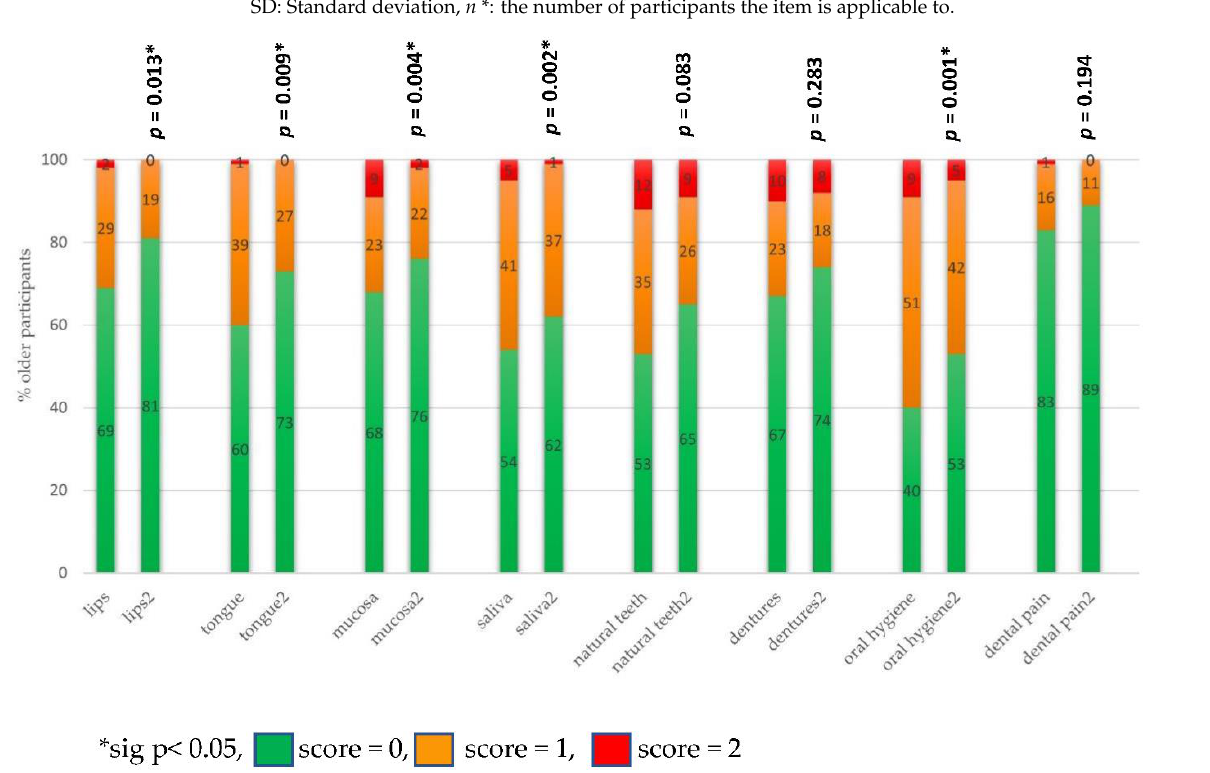
Figure 3. OHAT scores on different categories t0 and t1. Frequencies of the sum scores on OHAT at baseline and after 3 months were calculated. Participants scored lower sum scores after participating in the OCP: the mean OHAT sum score at baseline was 3.10 (SD 1.91) and 2.25 after 3 months (SD 1.63), a decrease of 0.86, which is a statistically significant improvement in oral health and hygiene ( t = 5.631 (146), p < 0.001). More in-depth multi-level analyses with the variance F-test, given in Tables 3 and 4, show significant effects for age, team, dental status and time, but not for ‘gender’ and ‘dental visit’. On average, the effect of ‘time’, after correction for other factors, resulted in an OHAT decrease of 0.82. Table 3. Results of the variance F-test.